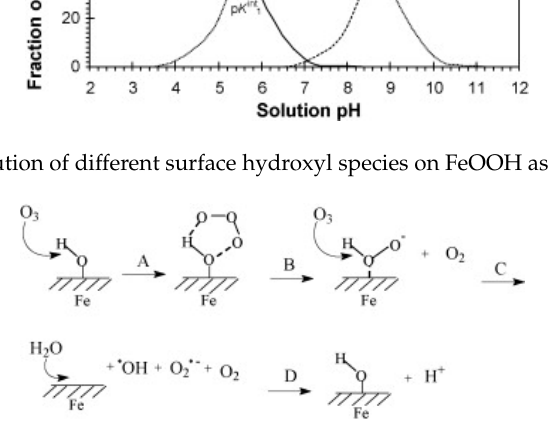
Figure 4. The possible pathway of hydroxyl radical generation.